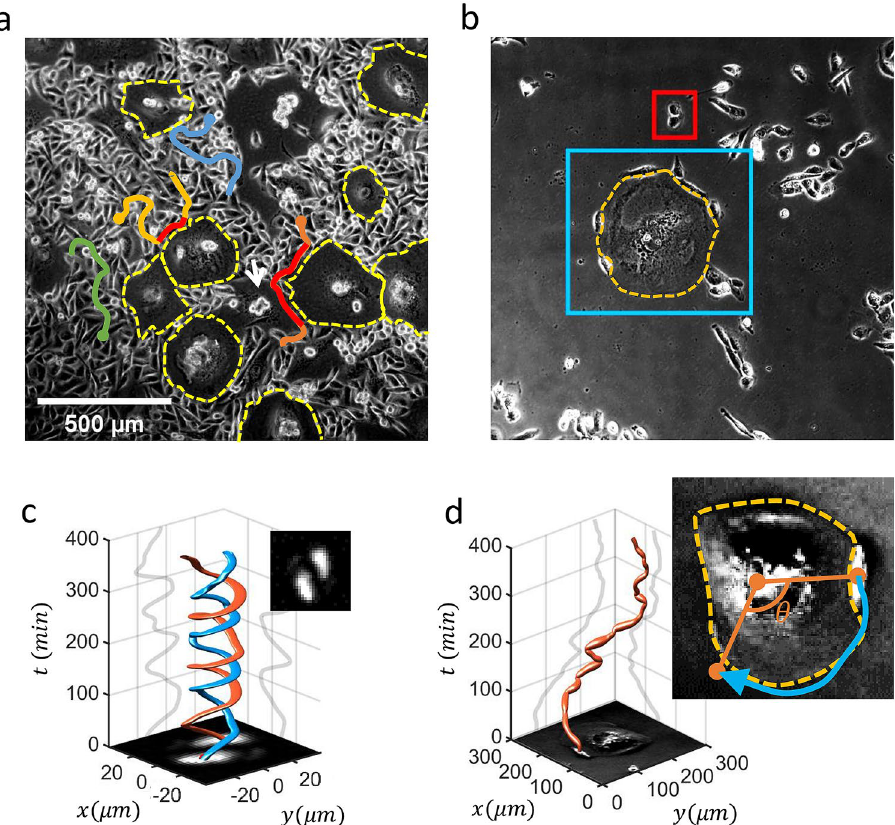
Figure 1. Binary (normal and senescent) mixtures of MDA-MB-231 cells and interesting pairwise cell motilities mediated by cell–cell adhesion. ( a ) A snapshot (phase-contrast) image of confluent monolayer MDA-MB-231 cell-culture (cell density = 526 cells/mm 2 ) including several cells that have undergone cellular senescence [hugely enlarged areas that very much appear to be empty spaces, free of cells, bounded by yellow dashed lines]. Senescent cells emerge randomly in time as well as in space. Four exemplary moving trajectories of normal cells within the population are superimposed on the snapshot image, traced with a time interval of 1 min. ( b ) A snapshot image of MDA-MB-231 cell culture at a much lower density (28 cells/mm 2 ), exhibiting ‘adhesive nature’ between adjacent cells. A pair of normal cells (bounded by a red box) and several normal cells travelling around a senescent cell (bounded by a blue box). ( c ) A pair of normal MDA-MB-231 cells showing active rotational movement. The centroids of the two cells are traced over 400 min. The thickness of the ‘colored tubes’ represents the instantaneous velocity of the rotating cell ( v = 1.19 μm/min, (cid:31) v 0.83 μm/min). ( d ) One = normal cell circling around an enlarged senescent cell (whose territory is marked by a dashed line). The snapshot images in ( c ) and ( d ) correspond to t = 0. The two gray lines in ( c ) and ( d ) are the projection of the cell traces on to the x–t and y–t plane. The cell trajectories in ( c ) and ( d ) were created using a MATLAB package “tubeplot” (by Anders Sandberg, http:// www. aleph. se/ Nada/ Ray/ Tubep lot/ tubep lot. html,